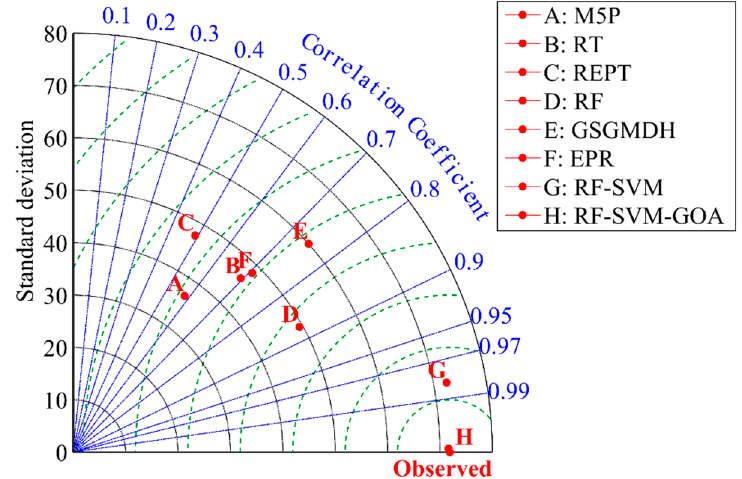
Figure 8. Taylor graph comparing different developed techniques in AIT forecasting (black lines = standard deviation, blue lines = correlation coefficient, and green lines = root mean square error (RMSE, Equation (19))).